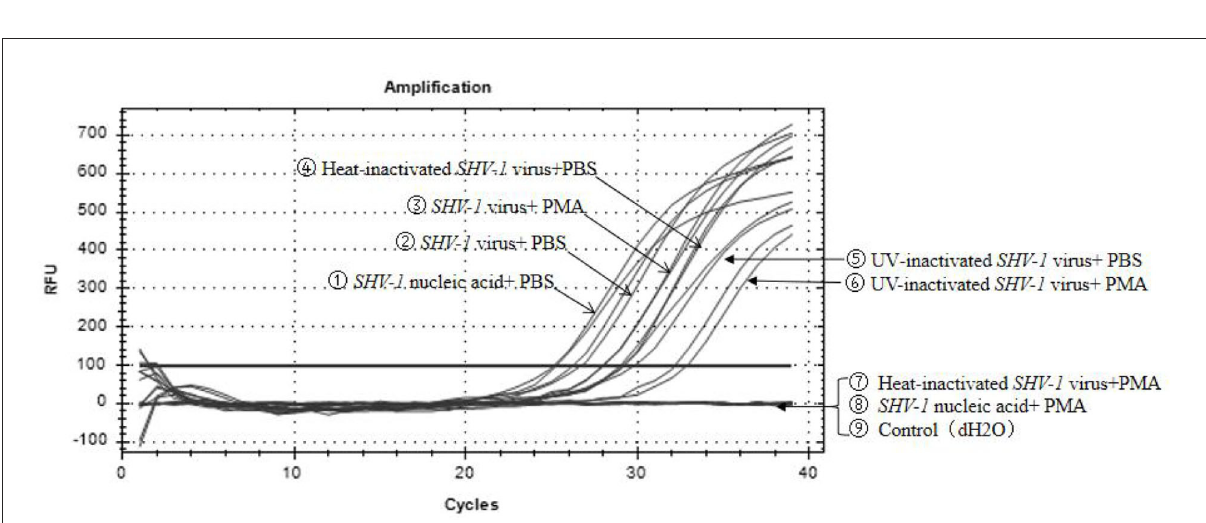
FIGURE2 Effect of PMA on qPCR detection of SHV-1. ‹ Infective SHV-1 virus + PMA group; › infective SHV-1 virus + PBS group; fi heat-inactivated SHV-1 virus + PBS group; fl UV inactivation SHV-1 virus + PMA group; (cid:176) UV inactivation SHV-1 virus + PBS group; – SHV-1 virus nucleic acid